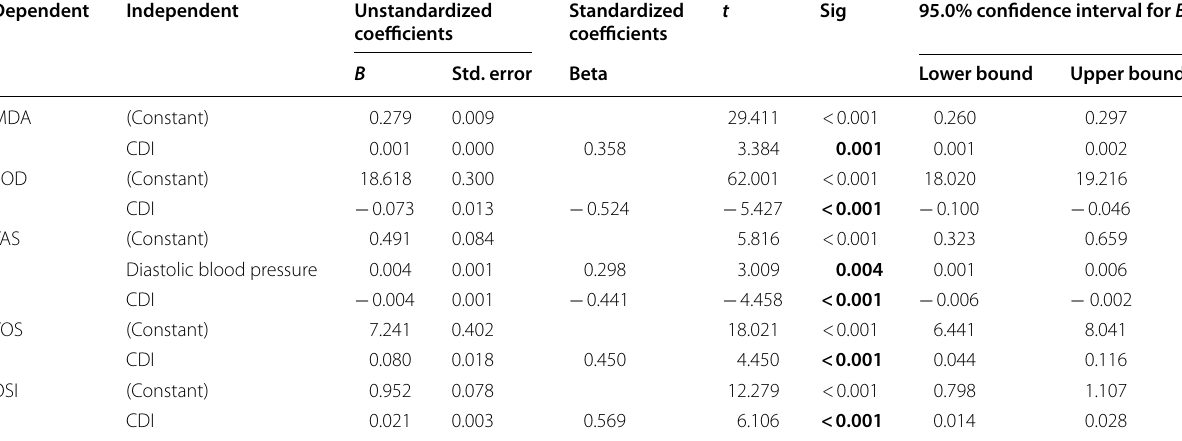
Bold indicates p -value Linear regression analysis